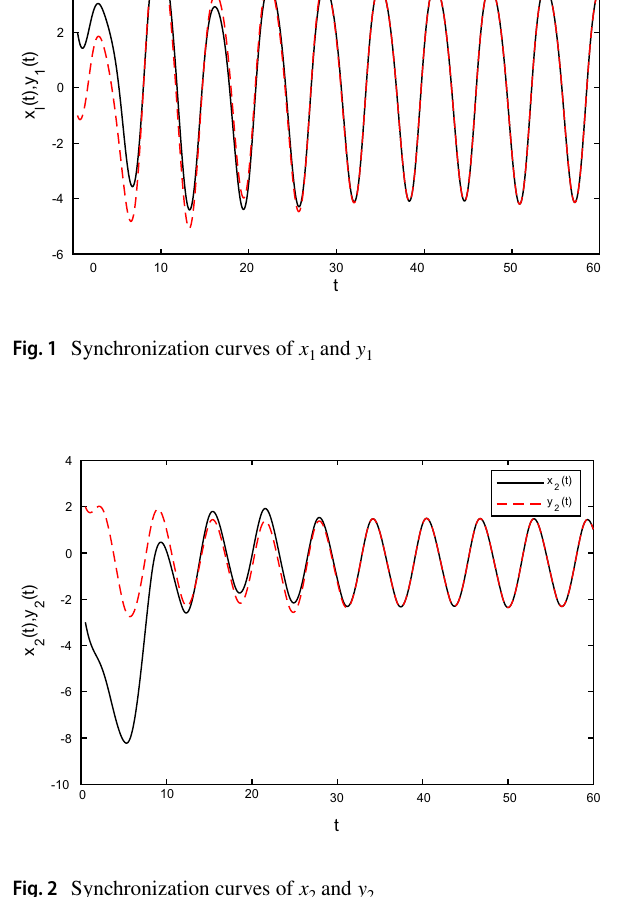
Fig. 2 Synchronization curves of x 2 and y